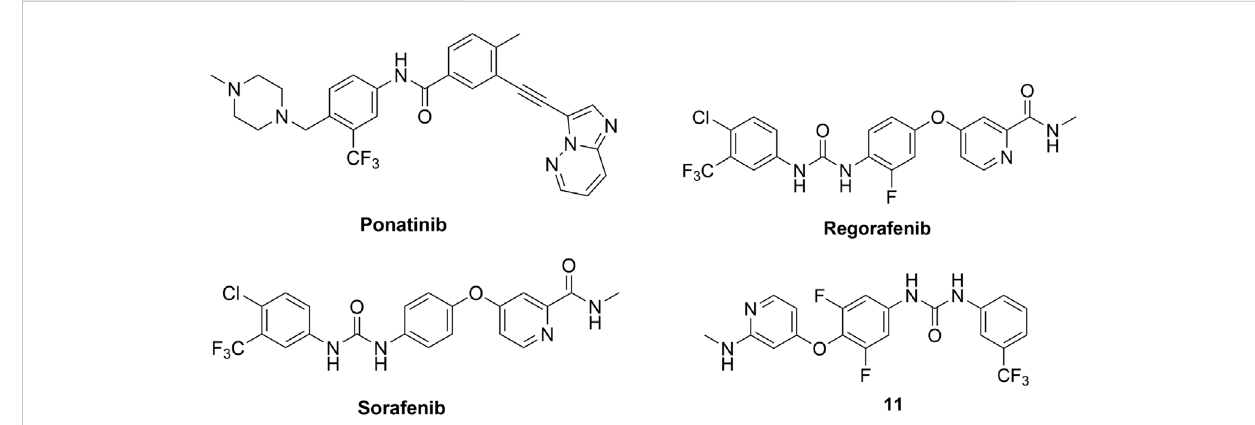
Structures of type II RIPK2 kinase inhibitors.